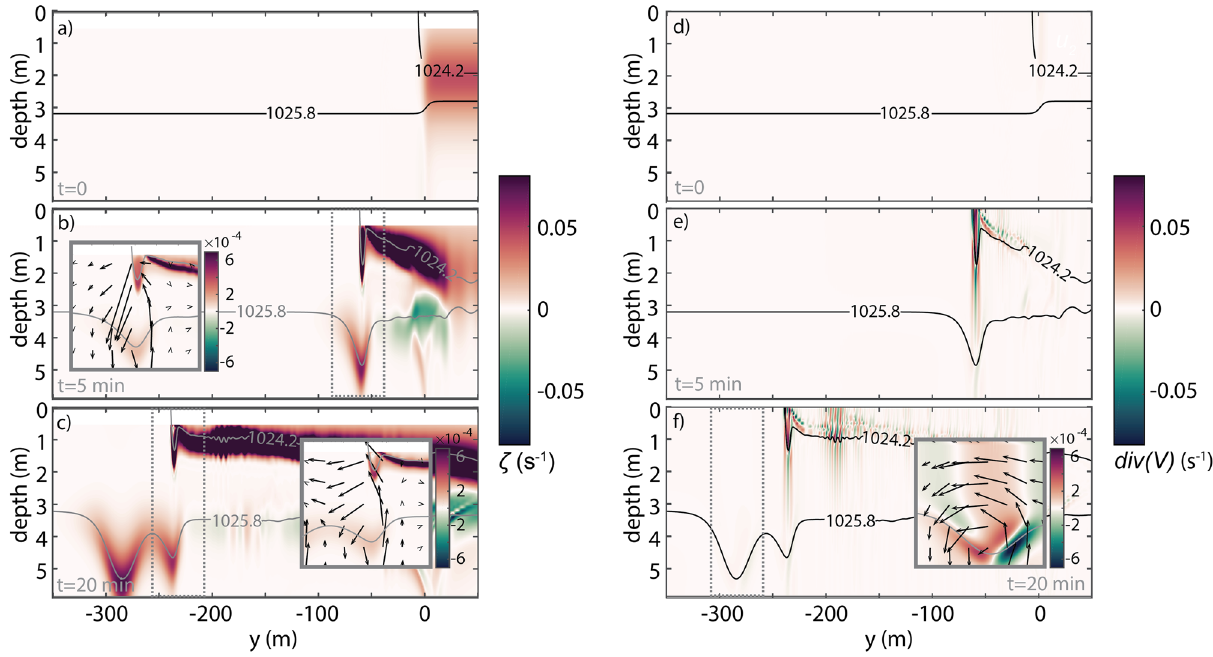
Figure 6. Vorticity and Horizontal Divergence. ( a – c ) Vorticity ζ and ( d – f ) horizontal divergence div ( V ) with reference density contours superimposed as grey/black lines. The top ( a , d ), middle ( b , e ), and bottom ( c , f ) panels represent the same time-lapses of Fig. 3. The insets on Fig. 5b,c,f highlight the vorticity and velocity field in the head of the front (dashed boxes) and the inset on Fig. 5f shows the horizontal divergence and velocity field in the internal solitary wave’s progression ahead of the plume front (dashed box). Note that not all the velocity vectors are shown and w . is increased by a factor of 5 for better picture